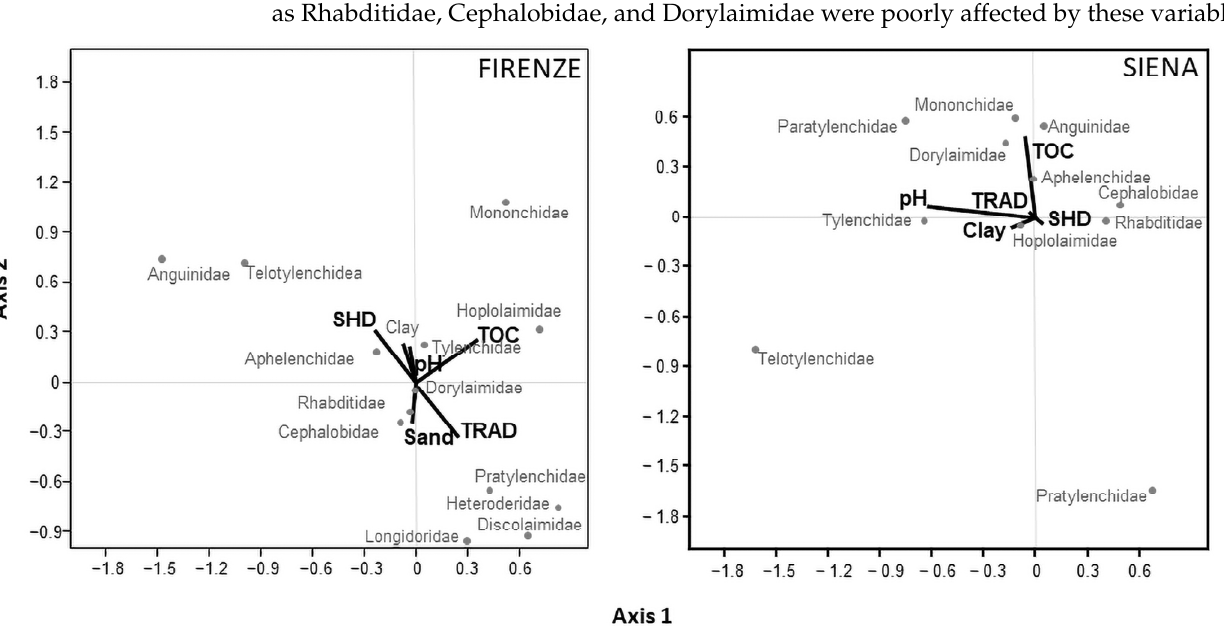
Figure 4. Scatter plots of CCA between soil properties and nematode taxa abundance. Foggia, per- centage of variance was 43.50% for axis 1 ( p < 0.05) and 38.67% for axis 2 ( p < 0.001). Ragusa, per- centage of variance explained was 32.61% for axis 2 ( p < 0.05), and no significance for axis 1. Trapani, percentage of variance was 48.99% for axis 1 ( p < 0.01) and 33.83% for axis 2 ( p < 0.001). In the FIR site, axis 2 was dominated by SHD (0.31), TRAD ( − 0.31), and TOC (0.25). The families of Mononchidae and Discolaimidae were mainly influenced by soil proper- ties such as TOC and sand, and to a lesser extent by SHD and TRAD management meth- ods. Instead, the plant-parasitic nematodes were mainly influenced by management. The families of Anguinidae and Telotylenchidae were positively related to SHD, while the families of Pratylenchidae, Heteroderidae, and Longidoridae favored TRAD management (Figure 3). In the SIE site, axes 1 and 2 were dominated by soil pH ( − 0.64) and TOC (0.49), respectively, and the families of Pratylenchidae and Telotylenchidae were inversely re- lated to TOC (Figure 3). In the FOG site, axis 1 was driven by clay (0.59), sand ( − 0.57), silt ( − 0.51), soil pH (0.52), SHD management (0.39), and TRAD ( − 0.39), while axis 2 was dom- inated by soil pH ( − 0.43). Significant community variables are reported as follows: (1) the plant-parasitic families Psilenchidae, Paratylenchidae, and Meloidogynidae were favored by the SHD system, (2) the families of Hoplolaimidae, Dorylaimidae, Pratylenchidae, and